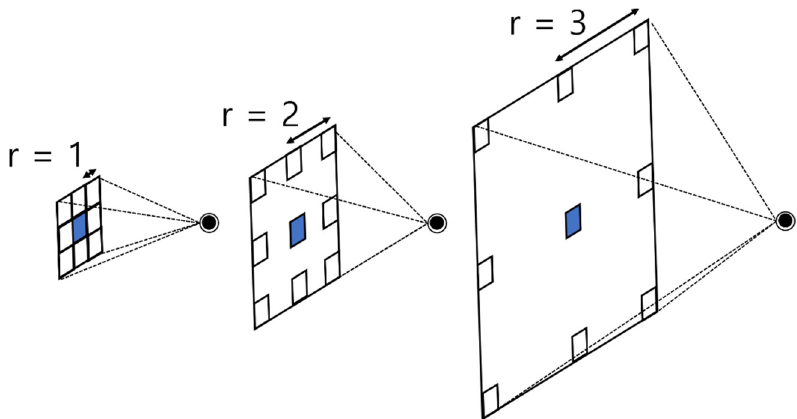
Figure 5. Atrous convolution.